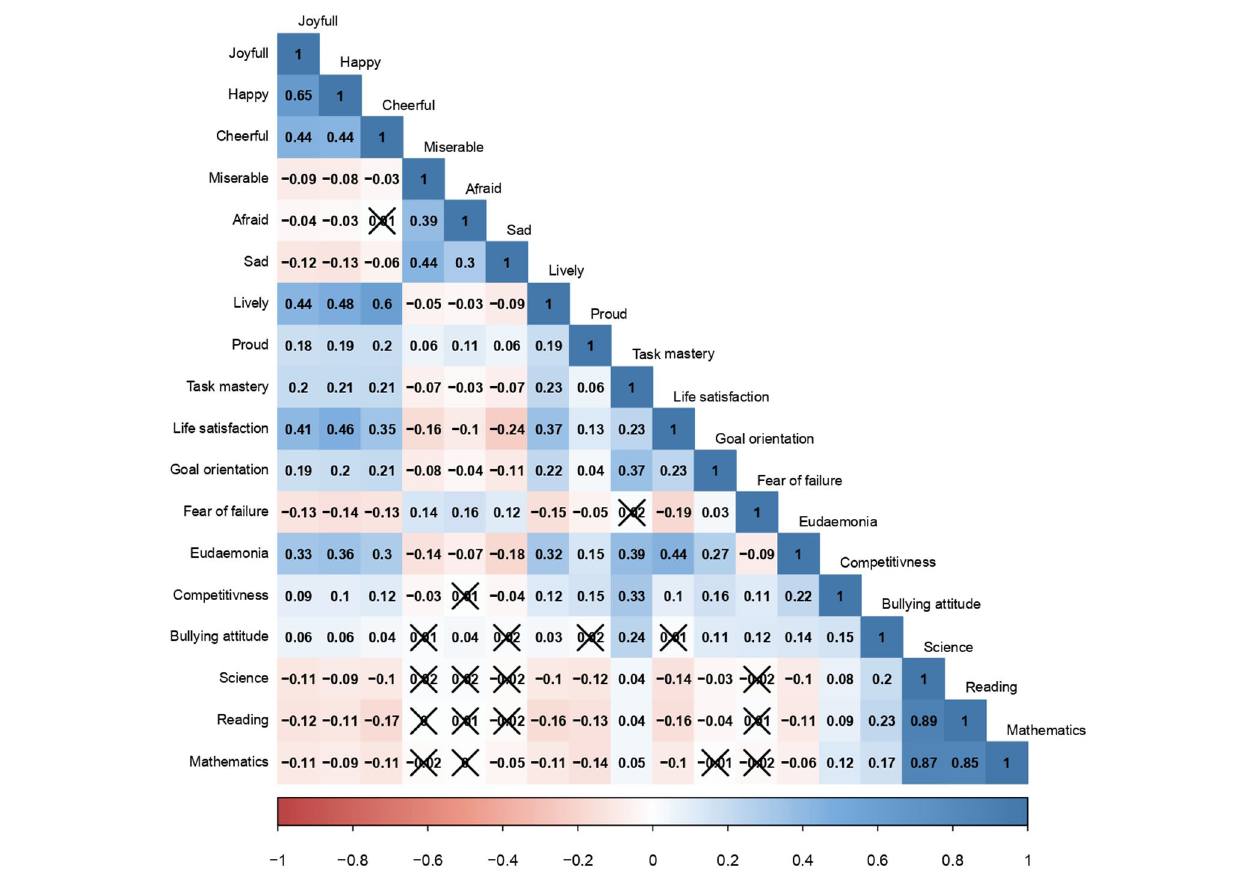
FIGURE 2 | Correlation matrix (Spearman’s rank correlation coefficient) of variables associated with bullying. Note: crossed cells refer to correlations that are not statistically significant. Source: Calculations of the authors based on PISA-2018 in Russia.